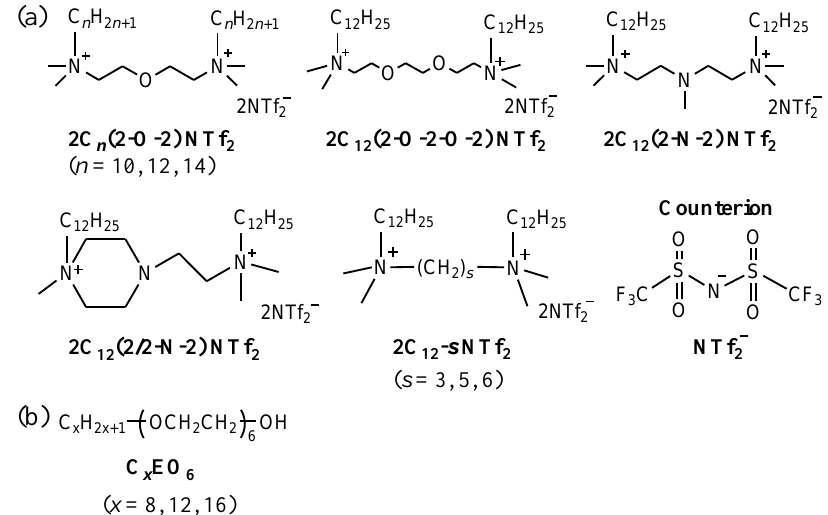
Figure 1. Chemical structures of ( a ) quaternary-ammonium-salt-type amphiphilic gemini ionic liquids and ( b ) nonionic surfactants.